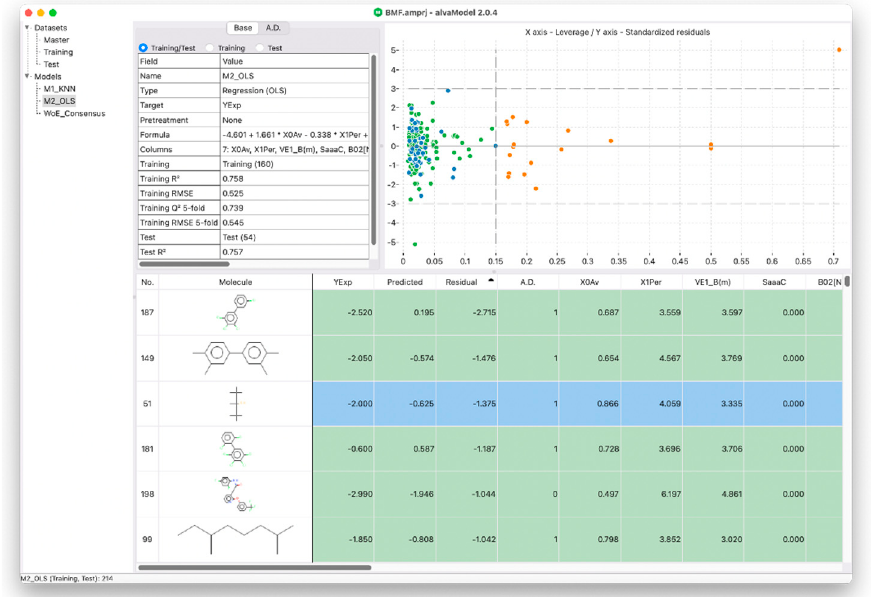
Figure 4. The graphical user interface of alvaModel showing a regression model with its parameters, metrics (scores), training and test molecules and their predicted and input values represented both with a grid and with a Williams plot.